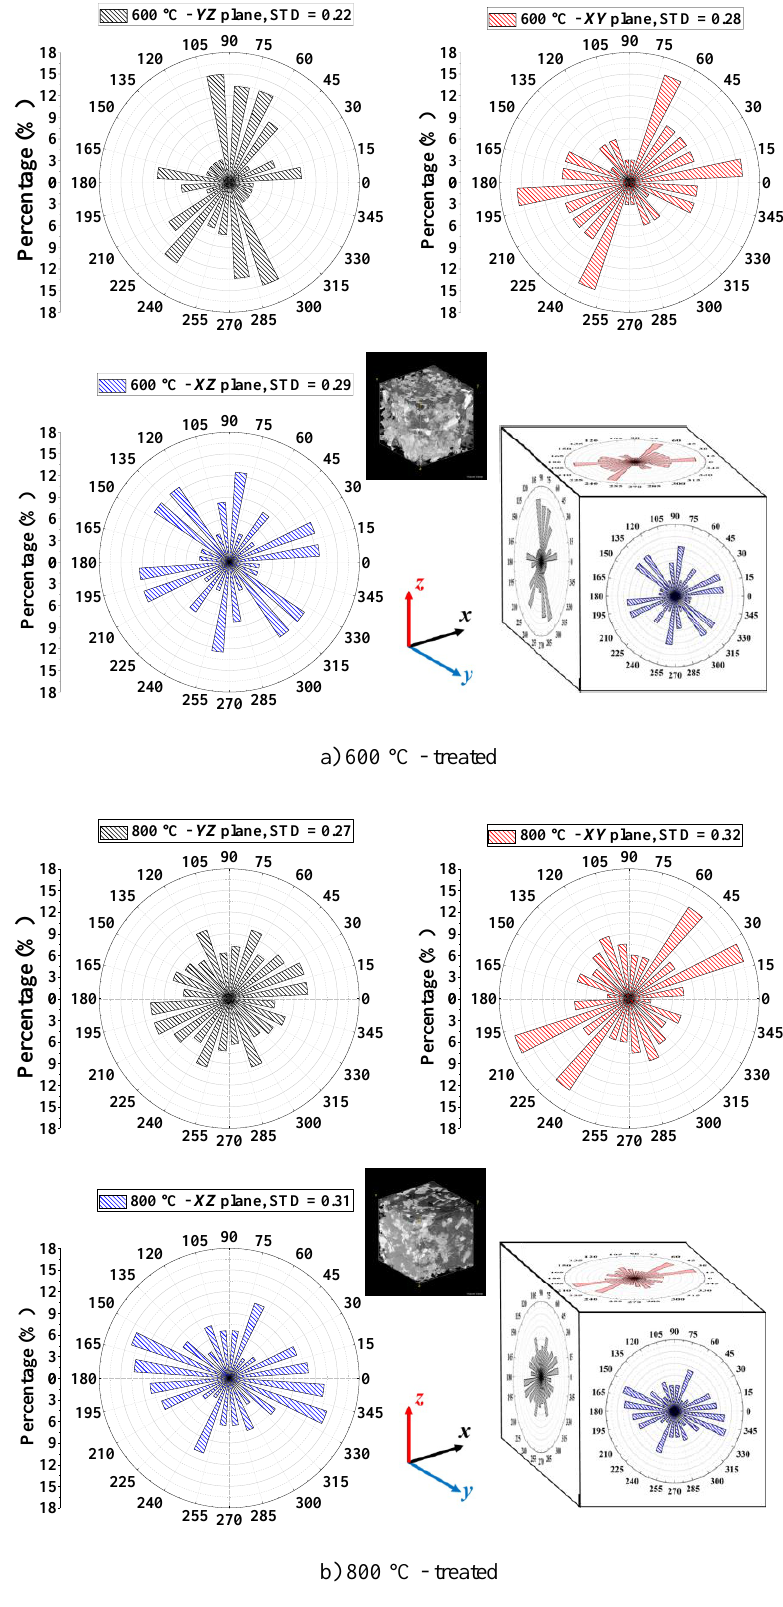
Figure 15. Orientations of major micro-cracks in ( a ) 600 °C and ( b ) 800 °C-treated SIC norite.